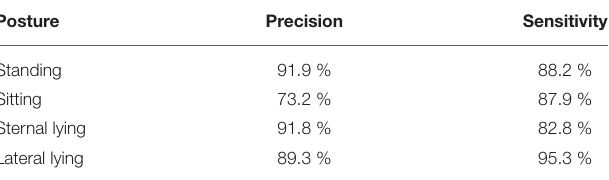
TABLE 3 | Precision and sensitivity of the posture prediction method. Posture Precision Sensitivity